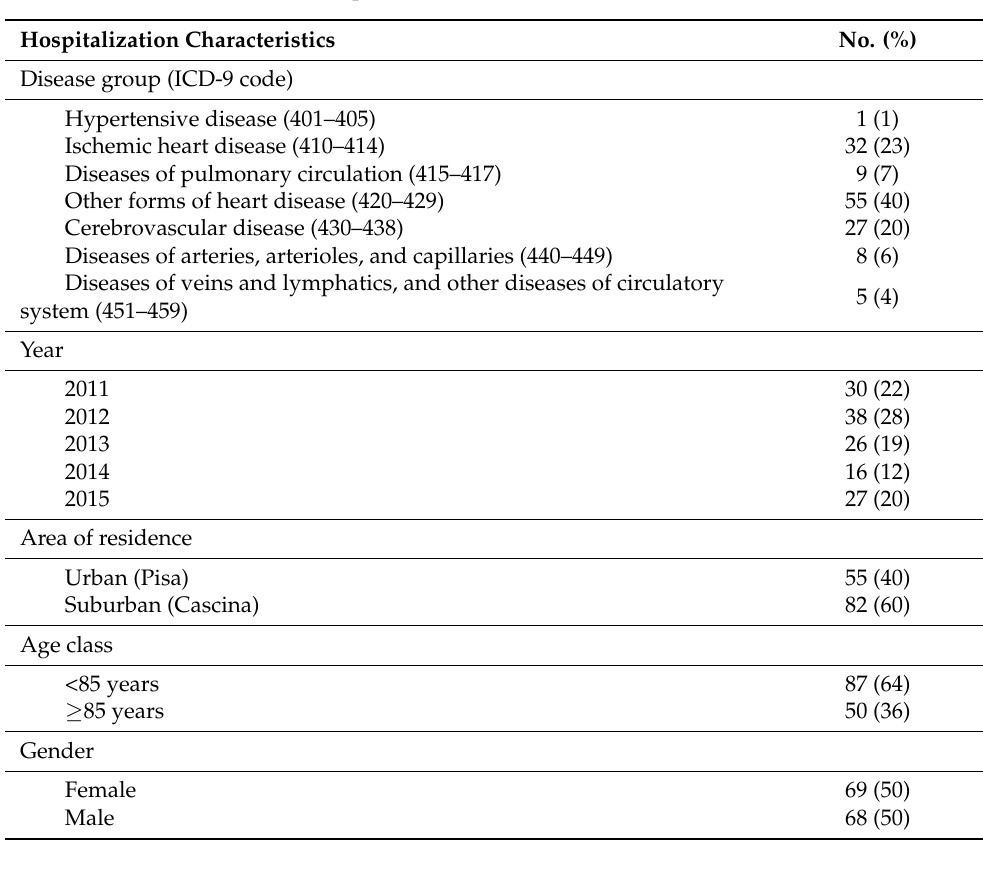
Table 1. Distribution of the 137 hospitalizations for acute cardiovascular